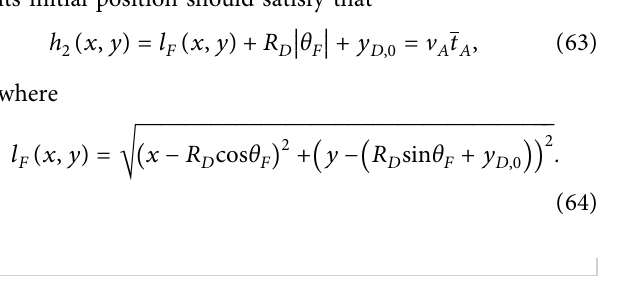
Figure 9: The barrier of the game with y